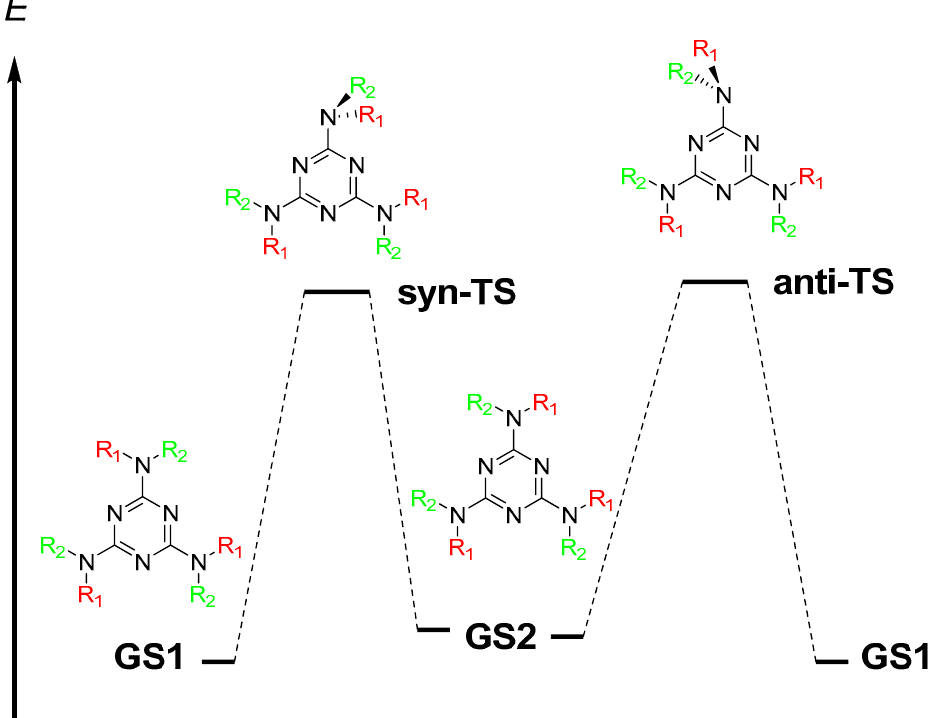
Figure 3. Hindered rotation in studied 1,3,5-triazines (GS1 is the symmetric conformer, GS2 is the asymmetric conformer, and syn-TS and anti-TS are the transition states).